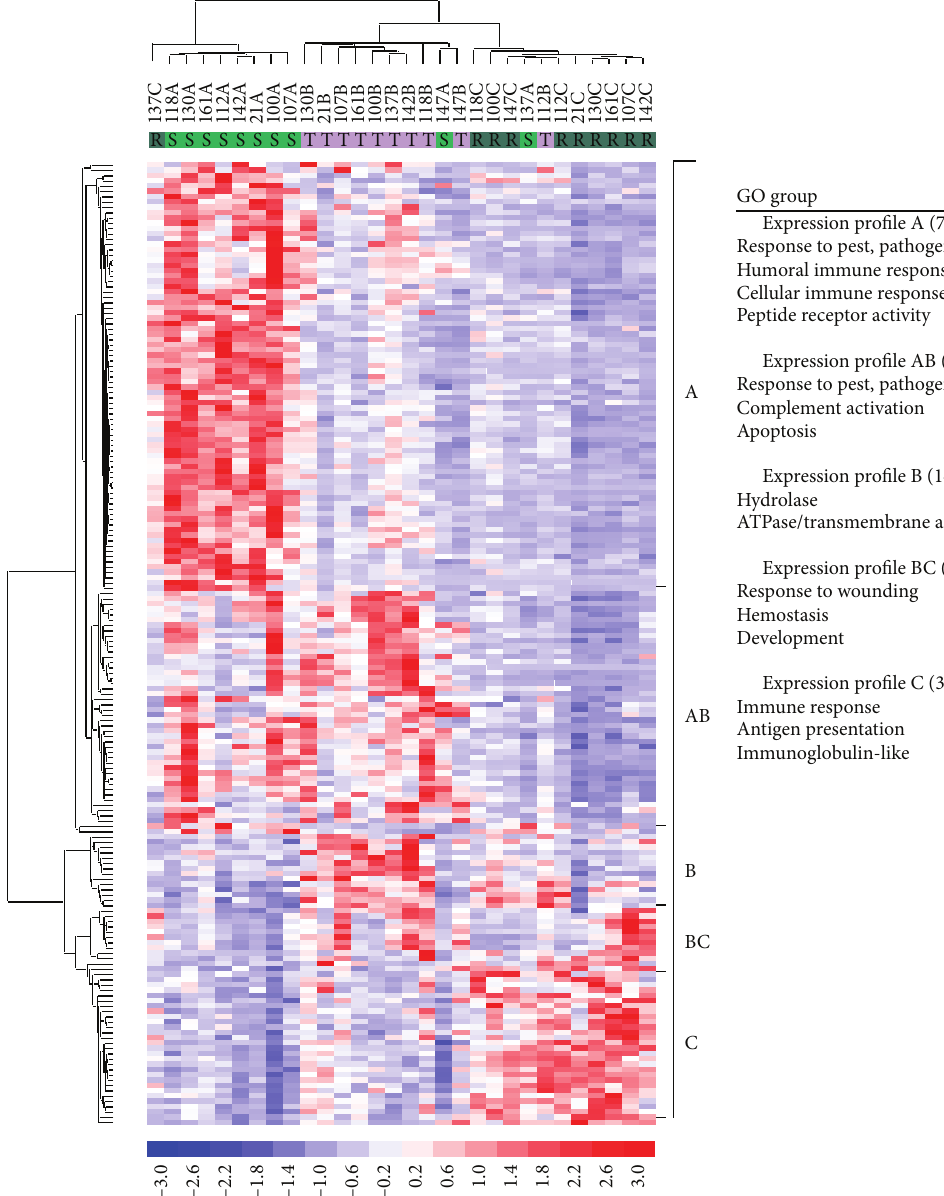
Figure 2: Heat map for changes in gene expression among subjects with uncomplicated malaria. Changes in gene expression with uncomplicated P. falciparum malaria revealed five major expression patterns: [A] genes upregulated at the time of acute illness, [AB] genes upregulated at the times of acute illness and treatment, [B] genes upregulated at the time of treatment, [BC] genes upregulated at the times of treatment and recovery, and [C] genes upregulated at the time of recovery. Based on Gene Ontology (GO) categories, profile A and AB genes were related to the immune response, AB genes to apoptosis, and C genes to immune-modulatory functions. In contrast, similar changes in gene expression were not observed in healthy control subjects without P. falciparum malaria (data not shown). Heat map for changes in gene expression among subjects with uncomplicated Plasmodium falciparum